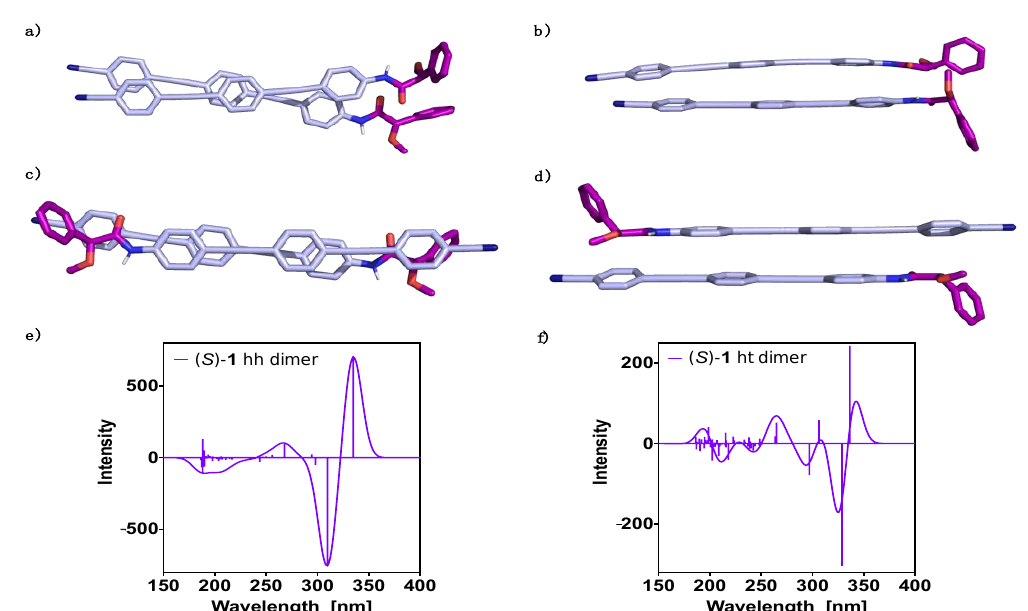
Figure 3. Oligo(phenyleneethynylene) (OPE) ( S )- 1 dimer DFT(B3LYP-D3)/6–31G** optimized geometries: ( a ) hh perpen- dicular view, ( b ) hh parallel view, ( c ) ht perpendicular view and ( d ) ht parallel view. TD-DFT (CAM-B3LYP)/3–21G ECD spectra evaluated at the DFT(B3LYP-D3)/6–31G** optimized geometries: ( e ) hh dimer and ( f ) ht dimer. No correction factors are included in the theoretical wavelengths.